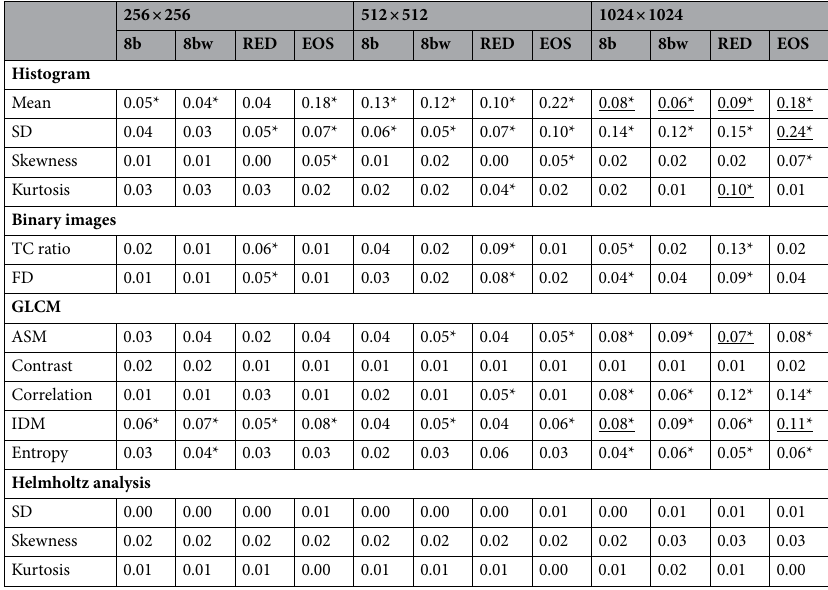
Table 1. Fisher score values for the image features. (*) Fisher scores above the mean Fisher score value (0.041). For comparison, top-10 important features obtained using random forest are underlined.